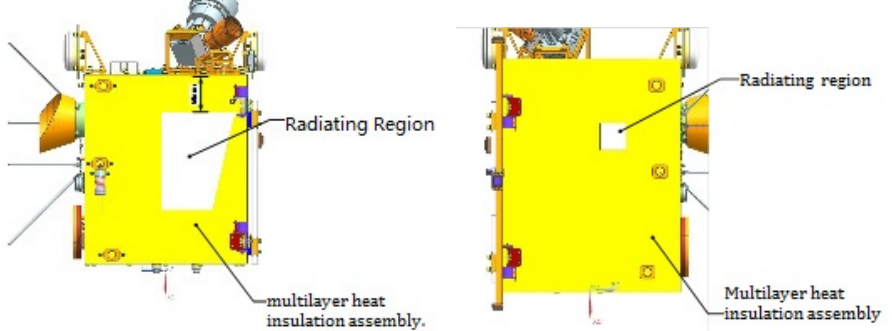
Figure 5. Radiating regions of the Luojia 1-01 satellite. ( a ) Radiating region of the +Y panel. ( b ) Radiating region of the –Y panel.